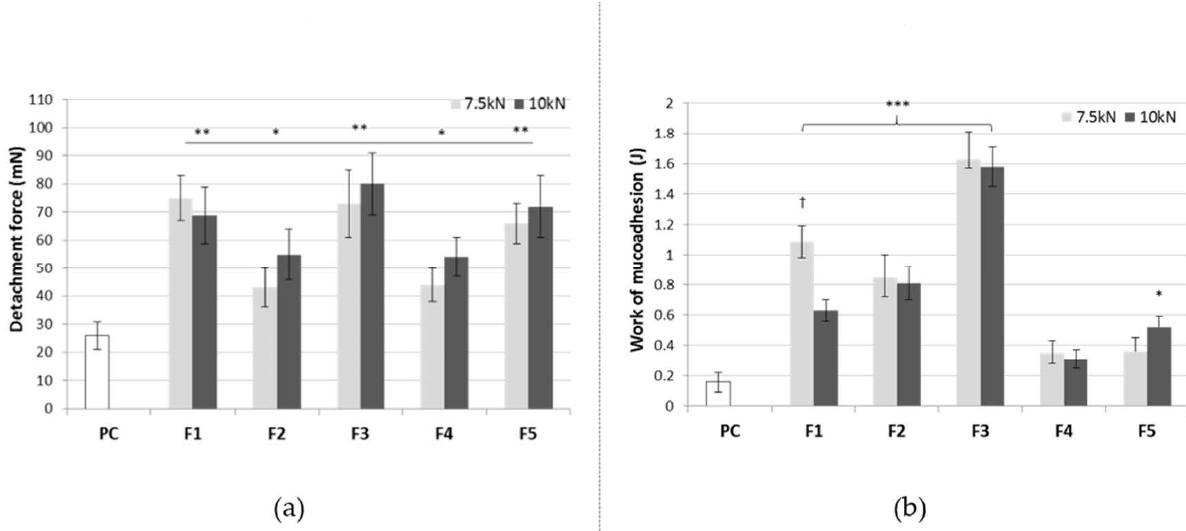
Figure 9. Maximum detachment force ( a ) and work of mucoadhesion ( b ) of tablets with resveratrol (F1–F5) compressed at different compaction forces (7.5 or 10 kN). Values are expressed as a mean ± SD; * represents significant differences with p ≤ 0.05, ** with p ≤ 0.01 while *** p ≤ 0.001 in comparison to control (cellulose paper, PC); † symbolizes significant differences with p ≤ 0.05 between the formulation compressed at 7.5 or 10 kN corresponding to the compression pressure 150 and 200 MPa, respectively.